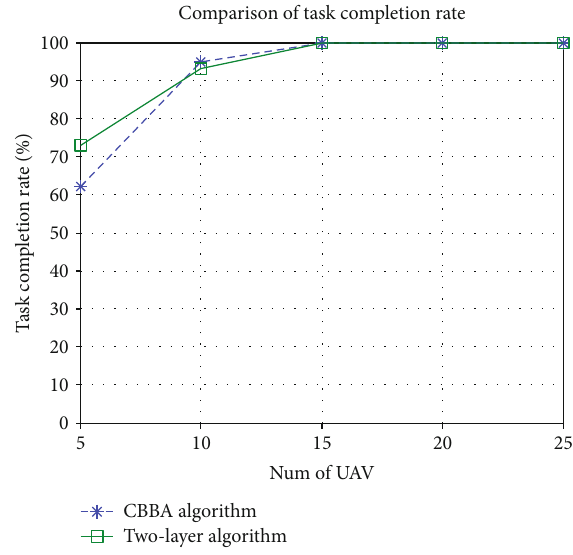
Figure 8: The comparison of task completion rate obtained by two types of